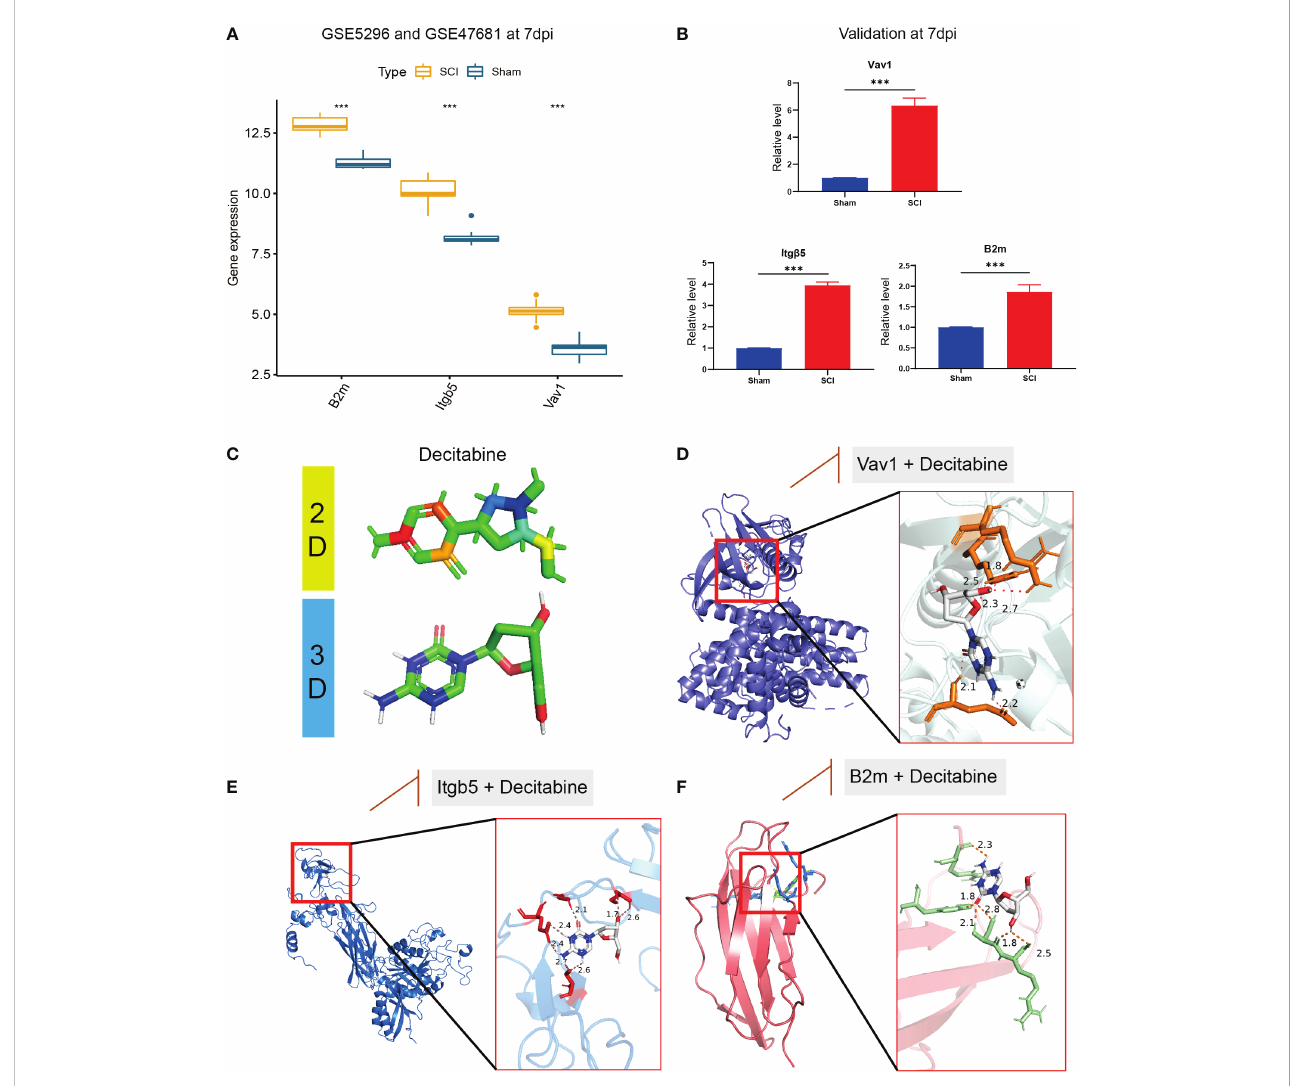
FIGURE 8 Validation of immune hub genes and drug prediction. (A) In the bulk RNA-seq datasets, B2m, Itgb5, and Vav1 were all highly expressed in the SCI group, (B) consistent with the validation results of qRT-PCR in 7 dpi. (C) The two-dimensional and three-dimensional structure of decitabine. (D – F) the possible binding sites of decitabine with B2m, Itgb5 , and Vav1 proteins. &Statistically signi fi cant difference appeared on this day. *** P <